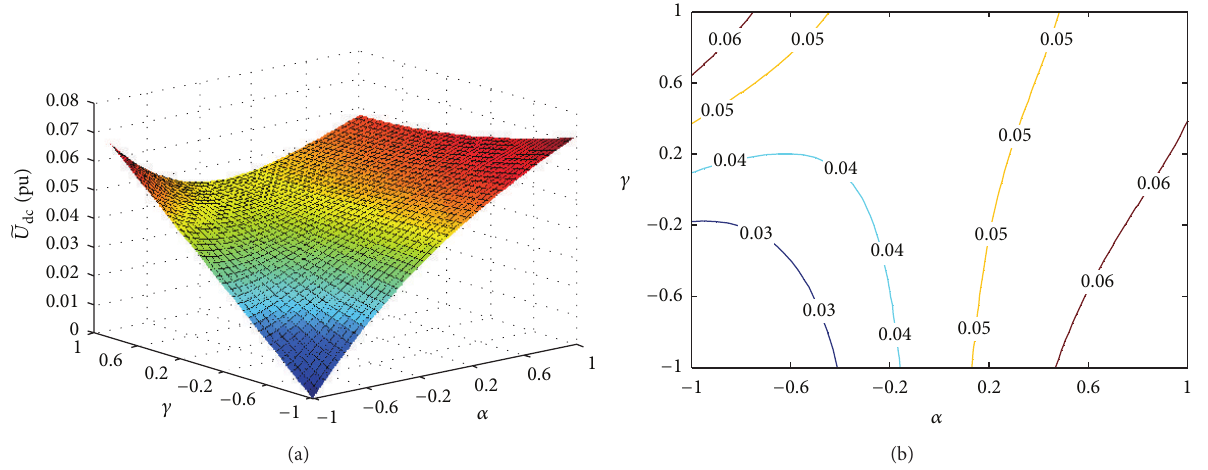
Figure 6: Three-dimensional mesh and contour lines of DC voltage fluctuation. (a) Three-dimensional mesh. (b) Contour